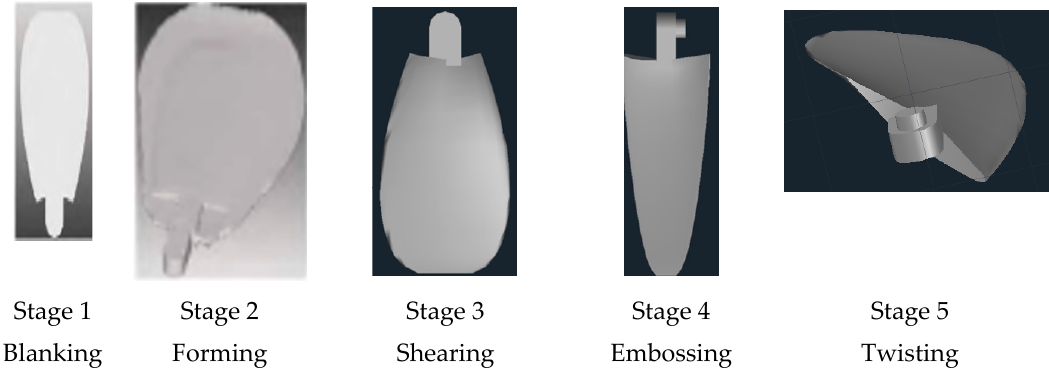
Figure 6. Formation of blade in five stages using cold forging process.